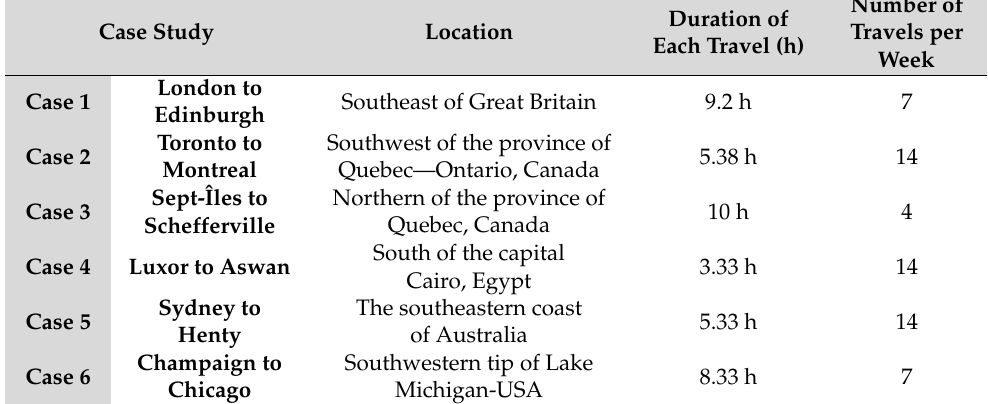
Table 2. The case studies and their characteristics [29,30].